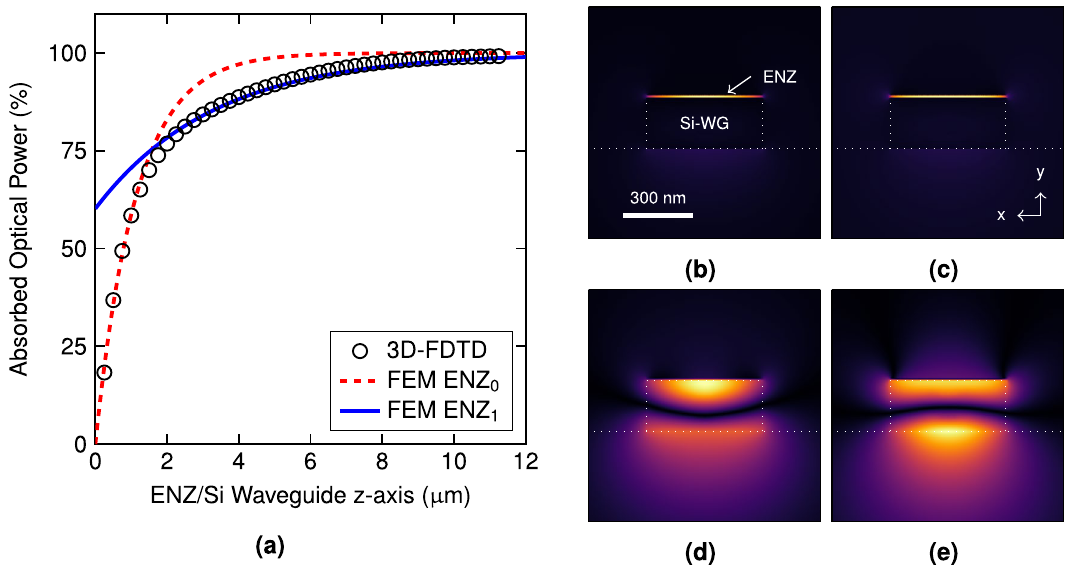
Figure 3. ( a ) Absorbed optical power by the ENZ layer along the ENZ/Si waveguide obtained by 3D-FDTD and fitting with the values of ENZ modes given by FEM. Normalized ( b ) | E y | and (d) | E z | field components of the ENZ 0 mode. ( c , e ) Same as ( b , d ) but for the ENZ 1 mode. The complex effective index (propagation loss) is 1.61 + j 0.109 (3.84 dB/ µ m) and 1.499 + j 0.038 (1.32 dB/ µ m) for the ENZ 0 and ENZ 1 modes,